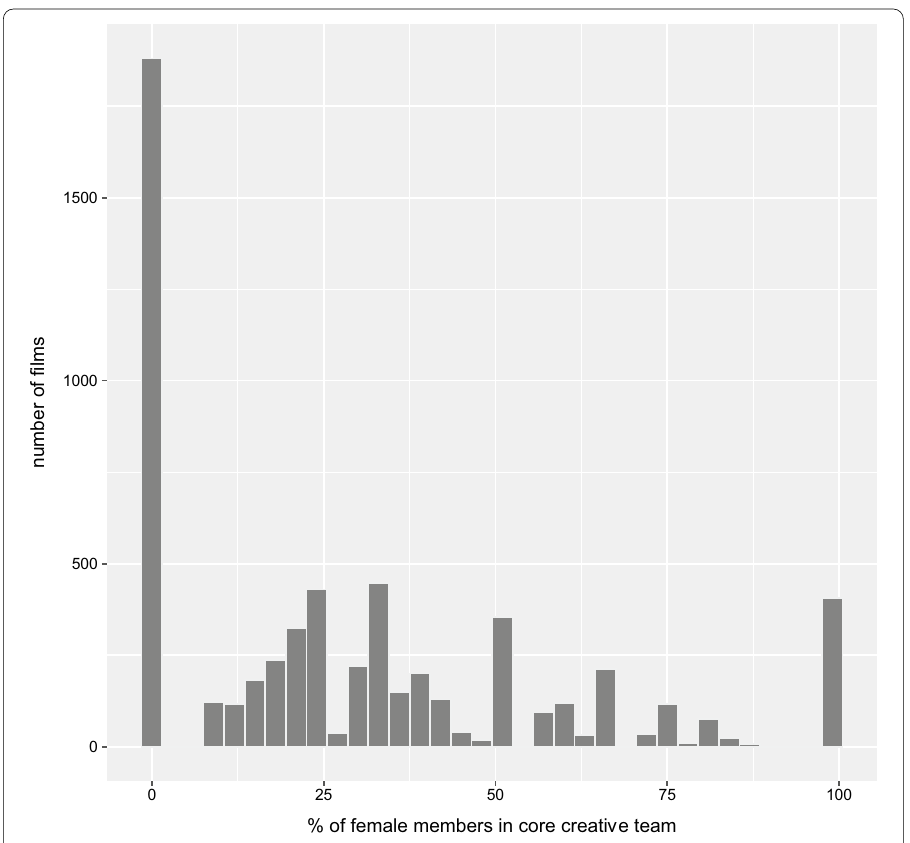
Fig. 9 Distribution of the share of women in core creative teams of 1323